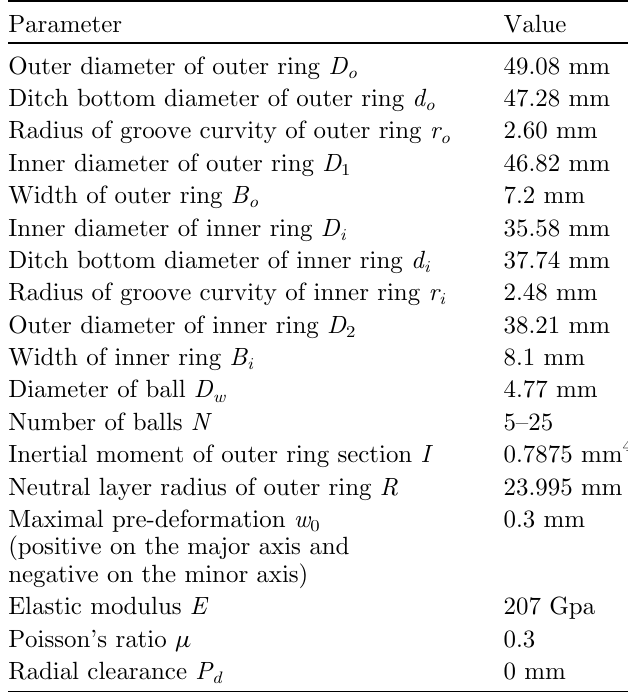
Table 1. Relevant Parameters of radial distributed load. Table 2. Main parameters of the